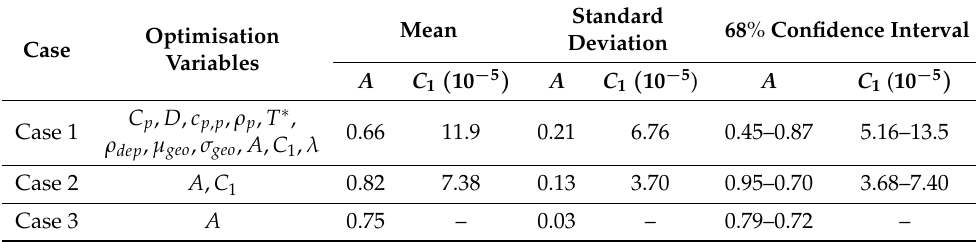
Table 5. Predicted model constants A and C 1 for the three hypothetical cases defined in Table